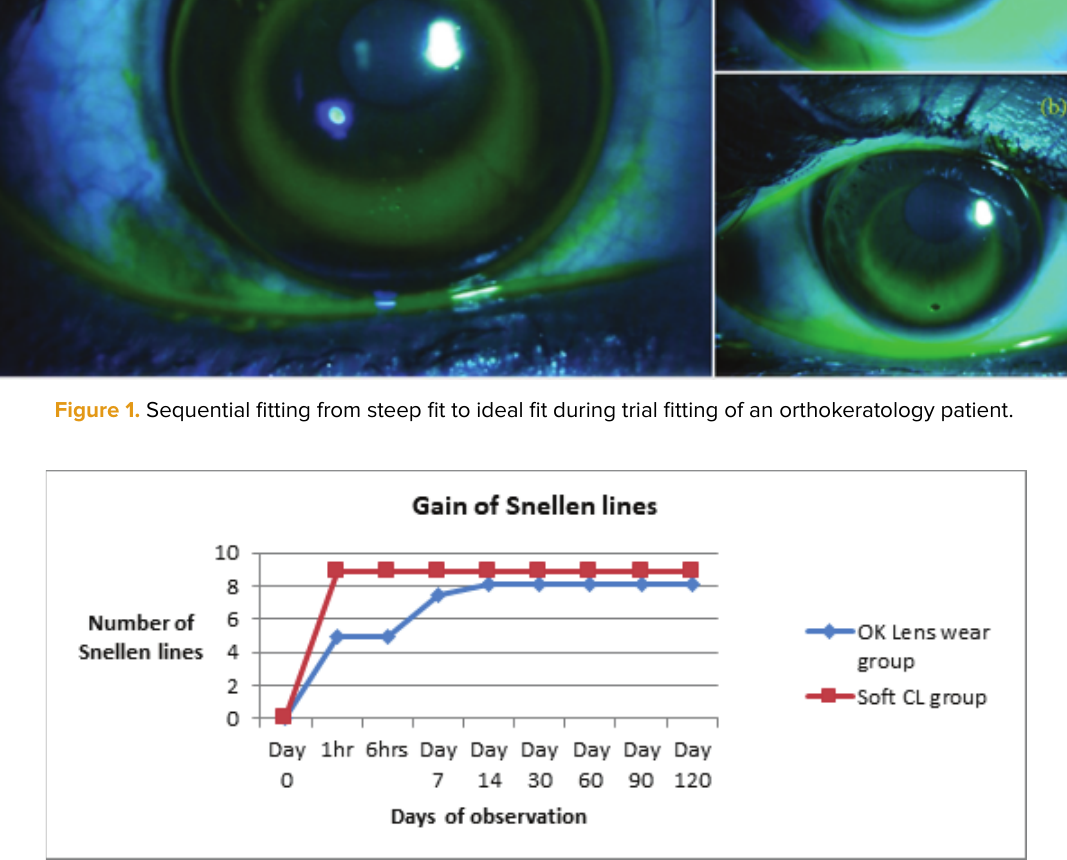
Figure 2. Gain in number of Snellen lines after lens wear. CL, contact lens; OK,